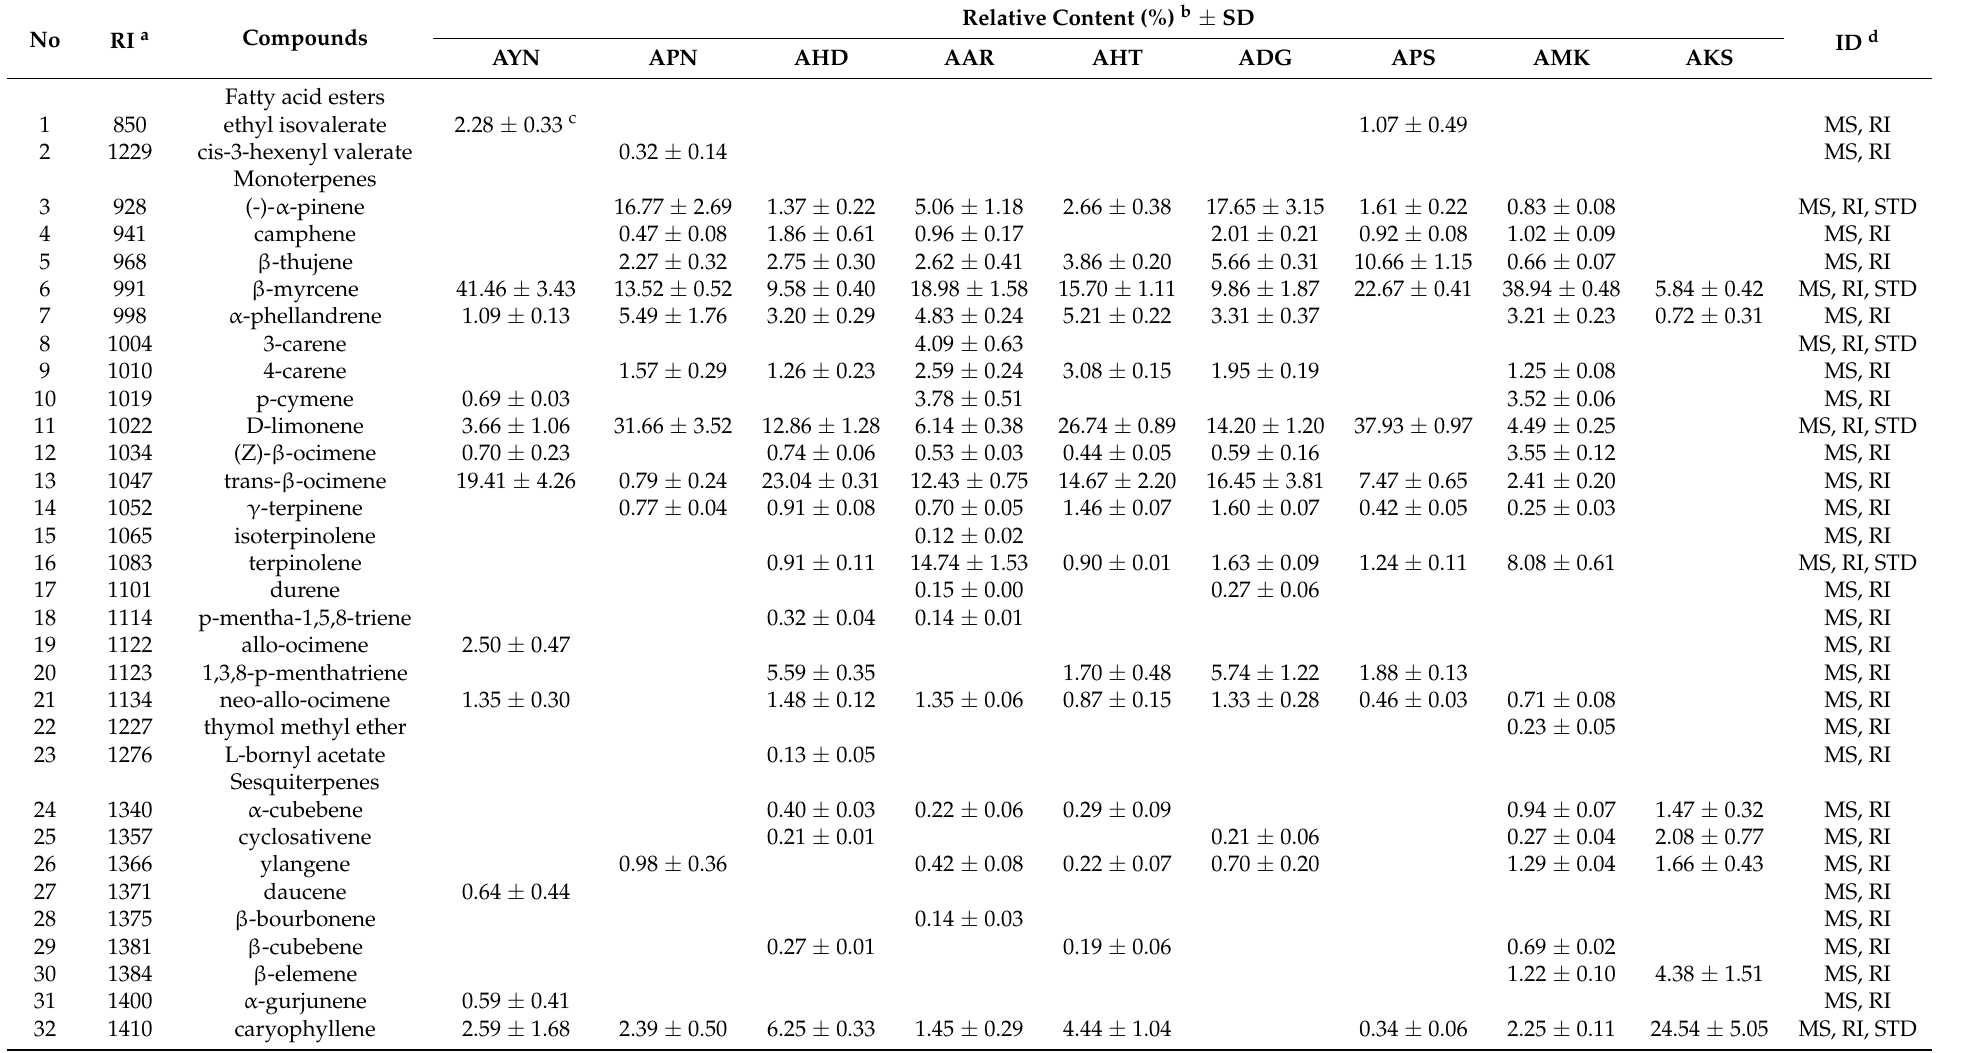
Table 1. Volatile compounds identified, and their contents in nine Aster species’